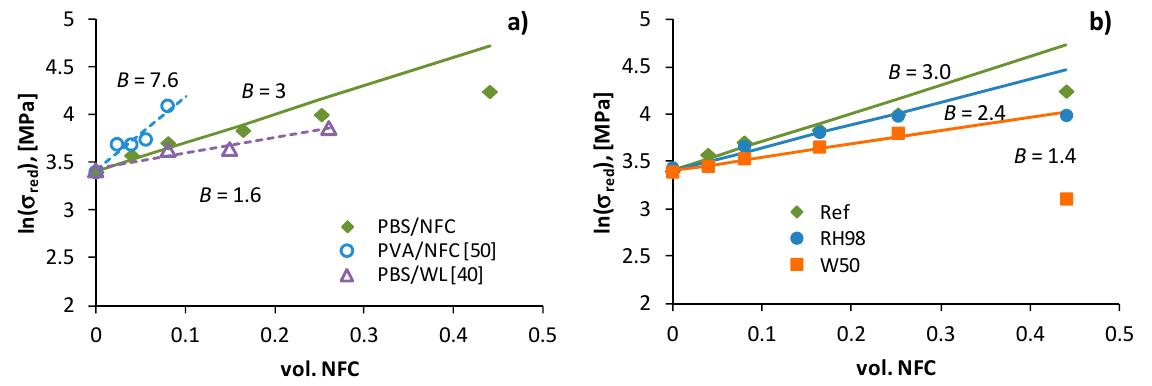
Figure 8. Reduced strength of composites as volume content of the filler for reference PBS/NFC, PVA/NFC [50] and PBS/WL [40] ( a ); and aged PBS/NFC ( b ). Lines are linear approximations with slope B .